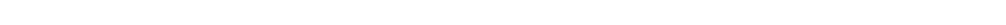
BOX 1 | The plant rhizosphere, a rich and heterogeneous environment. Many soil microorganisms are capable of colonizing the plant rhizosphere, the volume of soil under the influence of root activities. In the rhizosphere plants exert a selection on soil microorganisms by secreting around their roots a wide range of compounds known as plant exudates ( Figure 2 ). About 5–21% of the total carbon fixed by photosynthesis has been reported to be exuded at the root level and to influence the composition of the rhizosphere microbiota (Derrien et al., 2004; Vandenkoornhuyse et al., 2015). The exudates contain, among other things, nutrients but also signaling and chemo-attracting molecules. Along the root system, the exuded molecules are not evenly distributed. This leads to a heterogeneous root and rhizoplane colonization by selected microorganisms able to use the nutrients locally available. Some of these microorganisms will cooperate with the host plant through diverse mechanisms, like increasing the plant’s mineral and nitrogen nutrition, synthesizing phytohormones influencing plant phenotypes or stimulating the induced systemic response (Vacheron et al., 2013; Figure 2 ). The nature of the exudates will impact the composition and functions of the root-associated microbiota which in turn will affect the physiology of the plant, generating new exudates (Vacheron et al., 2013; Chaparro et al., 2014). Thus, the rhizosphere is a discontinuous environment both in space and time, rich in nutrients, locally increasing the growth of highly diverse microbial populations that are ultimately in constant competition for nutrients. These competitive conditions make the rhizosphere a hotspot for horizontal gene transfer (HGT, van Elsas et al., 2003), mutations or gene arrangements, and will drive bacterial adaptation and acquisition of new genes (Wisniewski-Dyé et al., 2011). The latter will result in population genotype and phenotype changes, in the modification of the structure and function of the community and hence, will have profound effects on the long-term evolution of communities. Nevertheless, understanding how rhizosphere community members may evolve, at a species, sub-species or even individual cell level, is still a complex issue. Right now, rhizosphere natural communities and plant rhizosphere systems have rarely been included in EE studies. But, thanks to the development of single cells sequencing, considering such complex and heterogeneous living system in EE studies is becoming feasible and will allow to obtain a comprehensive detailed view of rhizosphere communities functioning and driving forces ( Figure 1